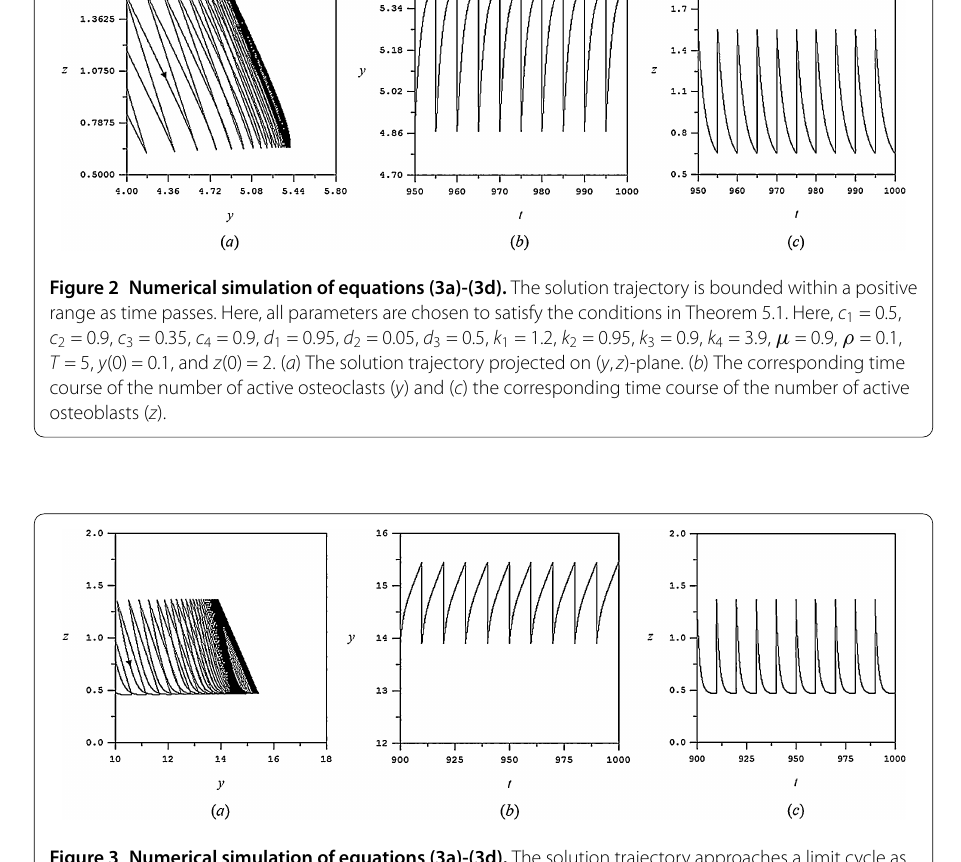
Figure 3 Numerical simulation of equations (3a)-(3d). The solution trajectory approaches a limit cycle as time passes. Here, all parameters are chosen to satisfy the conditions in Theorem 6.1. Here, c 1 = 0.7, c 2 = 0.2, c 3 = 0.35, c 4 = 0.9, d 1 = 0.95, d 2 = 0.005, d 3 = 0.7, k 1 = 1.2, k 2 = 0.35, k 3 = 0.9, k 4 = 3.9, μ = 0.9, ρ = 0.1, T = 10, y (0) = 0.1, and z (0) = 2. (a) The solution trajectory projected on ( y , z )-plane. (b) The corresponding time course of the number of active osteoclasts ( y ) and (c) the corresponding time course of the number of active osteoblasts ( z ) exhibiting sustained